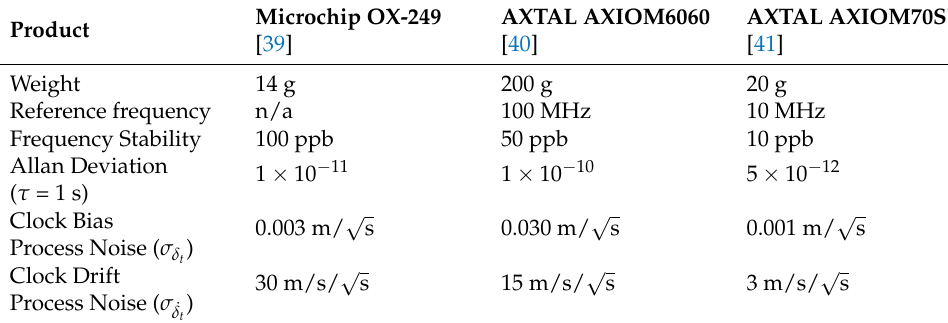
Table 5. Examples of space grade OCXO